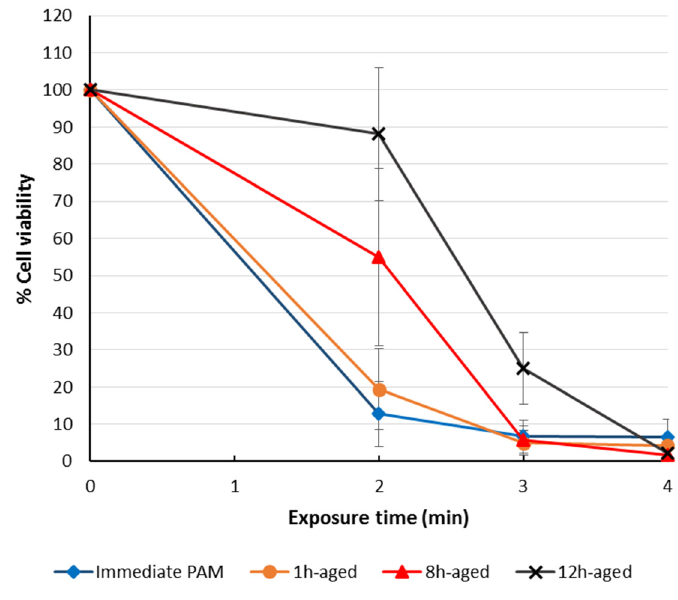
Figure 10. Effectiveness of stored/aged PTS (cell culture medium) to induce cell death in SCaBER cells for storage times of 1, 8, and 12 h, when measuring metabolic activity another 12 h later. Reproduced from [82] .